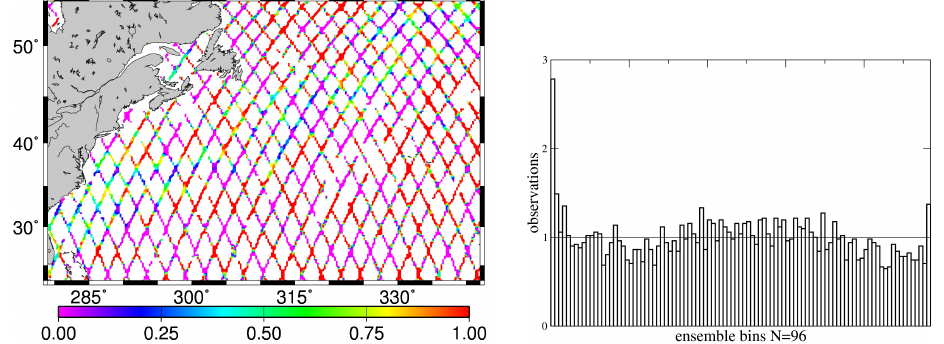
Figure 4. SSH Jason-1 tracks, local rank of the observations over 10-day Jason-1 cycle from 29 June to 9 July 2005 (left panel) and rank histogram over the Gulf Stream verification area (right